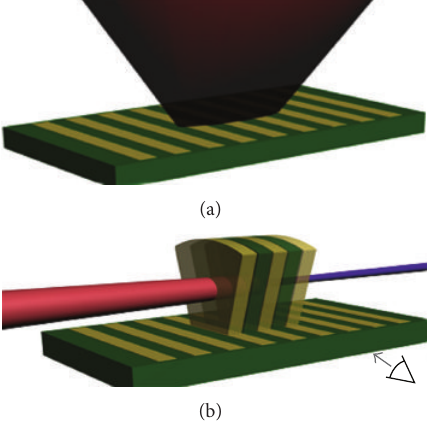
schemes is inevitably limited by dispersion in the medium.